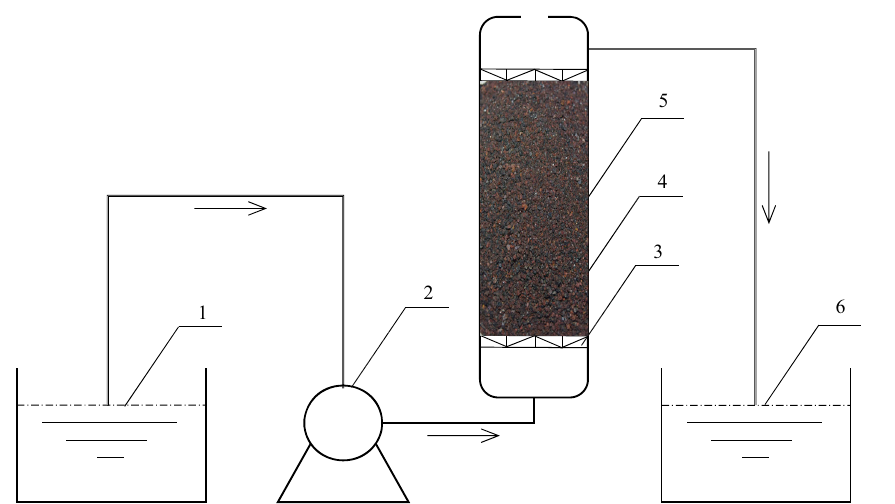
Figure 3: Schematic diagram of the fi xed - bed column system ( 1 – in fl uent tank, 2 – peristaltic pump, 3 – fi lter cloth, 4 – porous ceramsites, 5 – fi xed - bed column, 6 – e ffl uent tank )